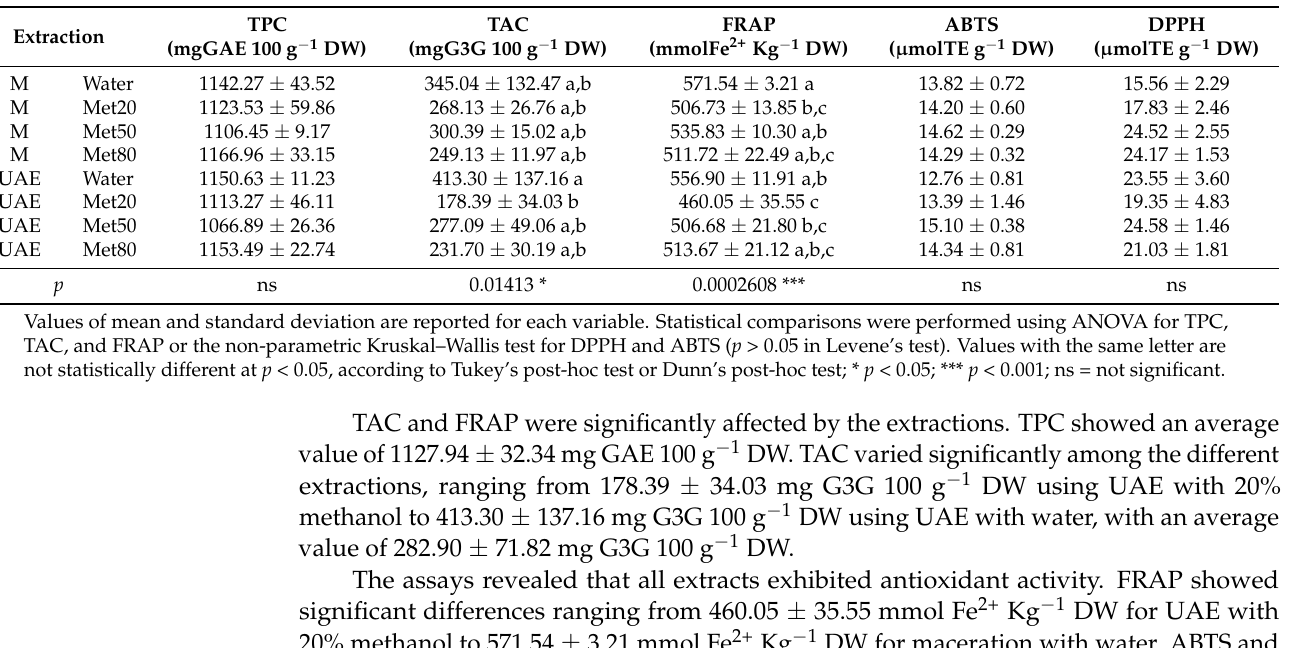
Table 1. Total phenolic content (TPC), total anthocyanin content (TAC), and antioxidant activity measured with the FRAP, ABTS, and DPPH assays, in dried tepal extracts obtained through maceration (M) and Ultrasound Assisted Extraction (UAE) techniques, and the solvents water or methanol at three concentrations (20%—Met20, 50%—Met50, and 80%—Met80). Extraction